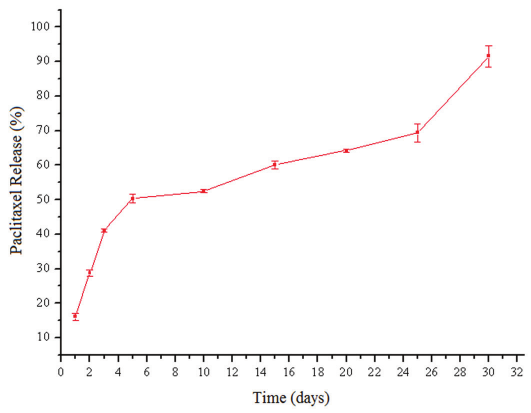
Figure 7. Time-dependent release of paclitaxel in vitro . The points are the mean ± SD of n = 3